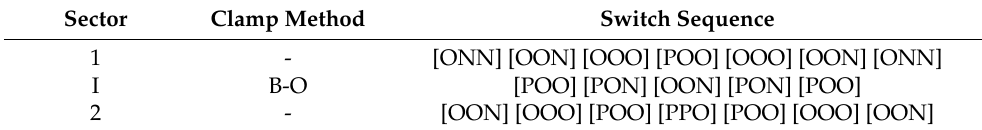
Figure 9. Operation of reference voltage vector in sectors 1 and 2. ( a ) The reference voltage vector is in the undistorted region of sector 1 ( b ) The reference voltage vector is in the distortion region I ( c ) The reference voltage vector is in the undistorted region of sector 2